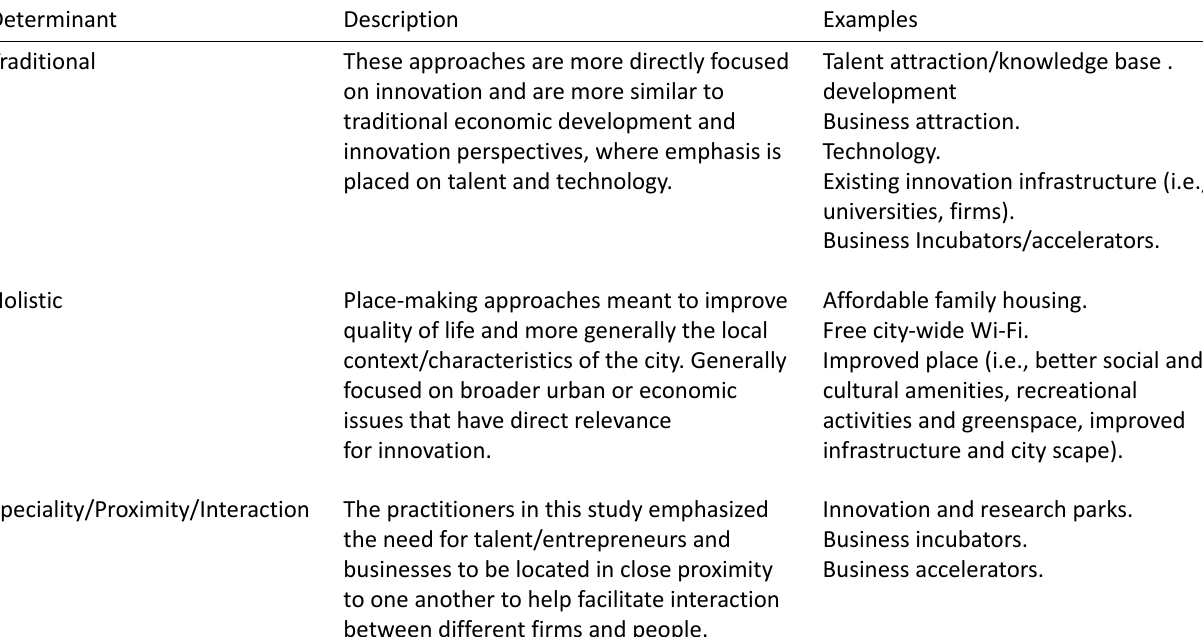
Table 3. Summary of key determinants of